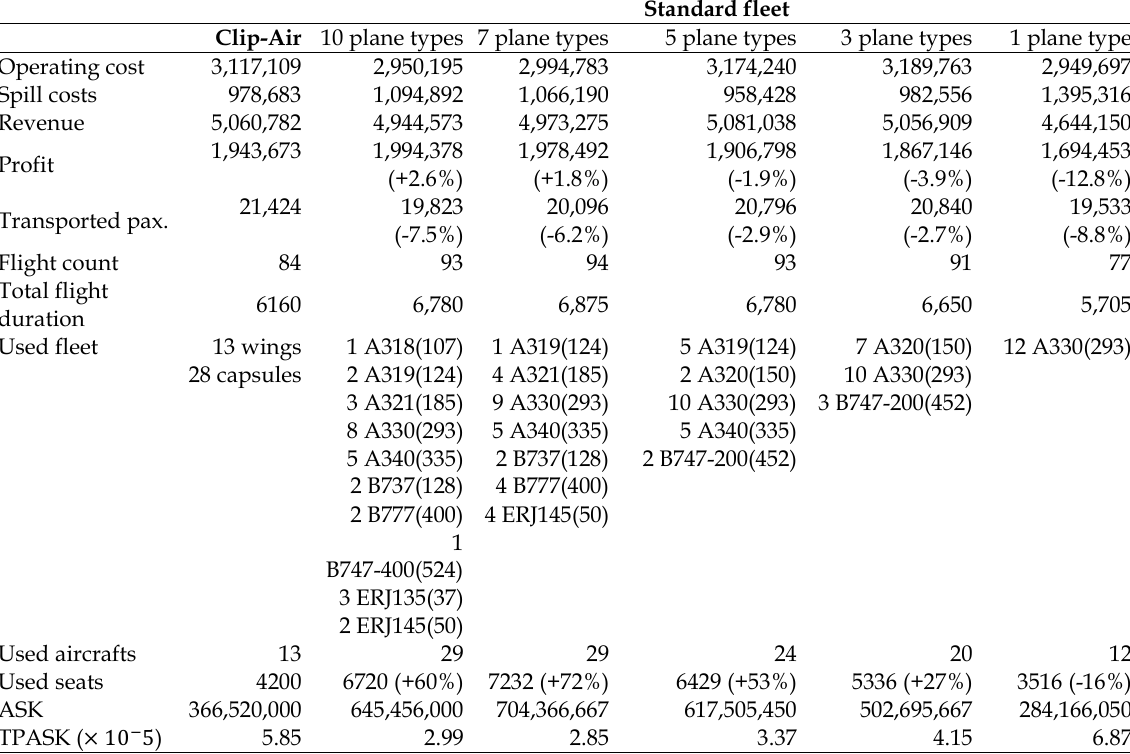
Table 10. Results with varying standard fleet